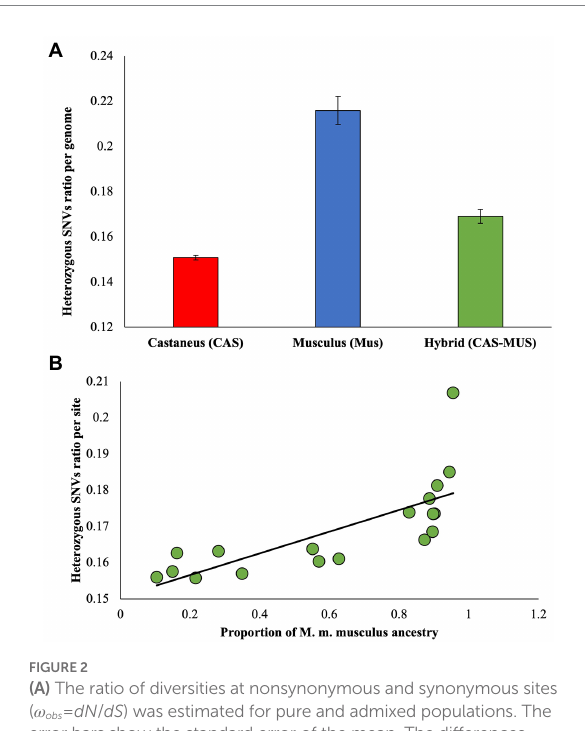
FIGURE 2 (A) The ratio of diversities at nonsynonymous and synonymous sites ( ω obs = dN / dS ) was estimated for pure and admixed populations. The error bars show the standard error of the mean. The differences between dN / dS ratios of the hybrid and M. m. musculus ( p < 0.00001) and that between the hybrid and M. m. castaneus ( p < 0.00001) populations were significant. (B) Correlation between the proportion of M. m. musculus ancestry/admixture and the dN / dS ratio estimated for admixed individuals. The relationship was highly significant ( rho = 0.89, p < 0.00001), and the best-fitting curve is shown. FIGURE 3